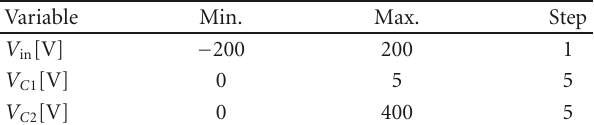
Table 2: Lookup table for simulation of the first block (size 2 MB).